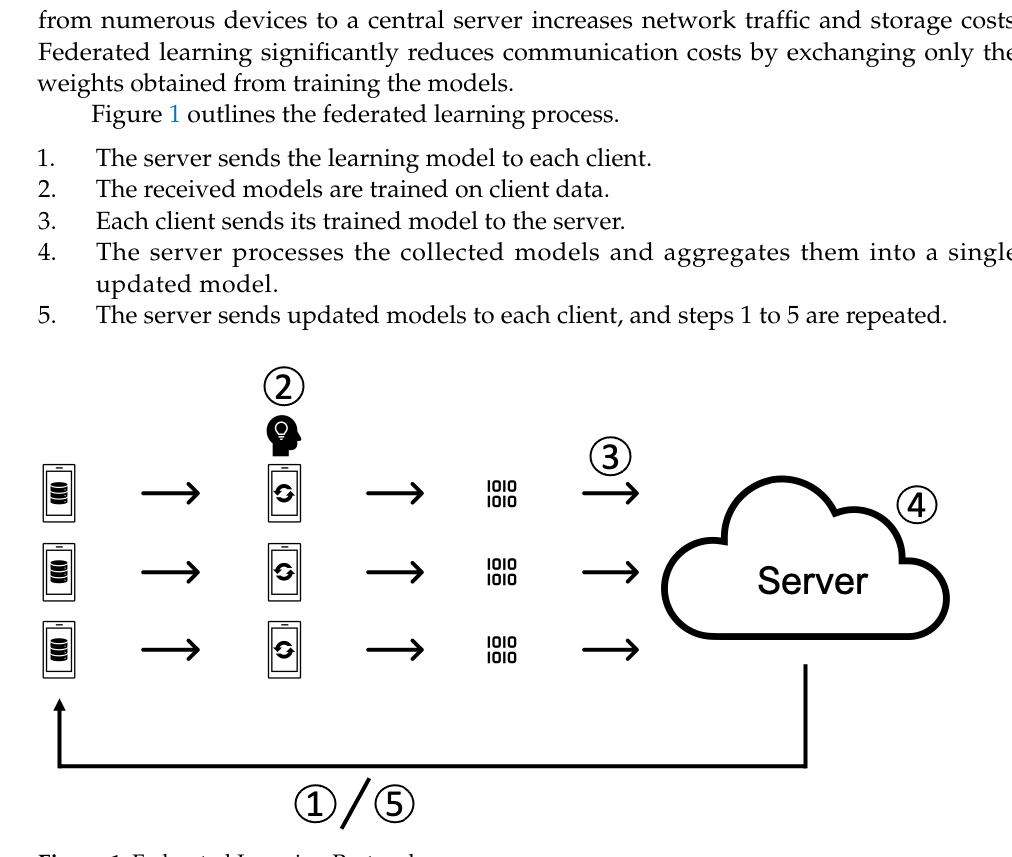
Figure 1. Federated Learning